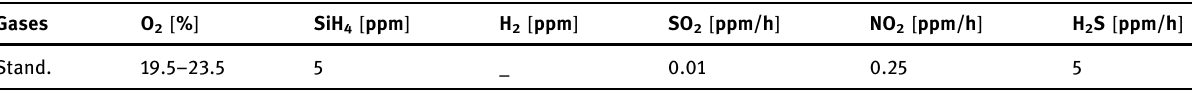
Table 1: America air quality standards for gases ( NAAQS ) Gases O 2 [ % ] Stand.